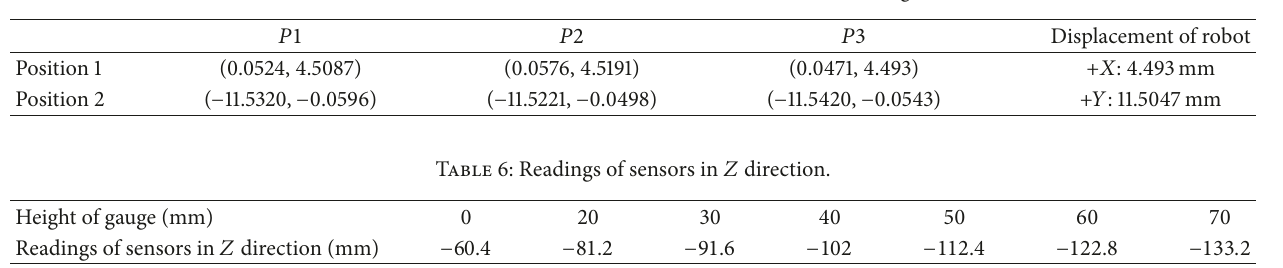
Table 5: The difference of coordinates before and after moving.